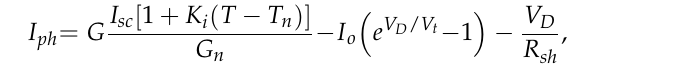
Figure 5. Array control through fixed droop and virtual inertia control. The signal Δ P_PV , from plant control, as shown in Figure 3, is shared among the arrays by the ratio of reserve power from each array to the total amount of reserve of the entire plant. Certain arrays of the plant may be completely or partially shaded and, hence, their temperatures will also be different, as will their power output and reserve levels. Thus, the set-point from plant control is divided among the arrays in proportion to their reserves such that the array with largest amount of reserves participates more. This gen- erates the signal Δ P sec , as shown in Figure 5, using